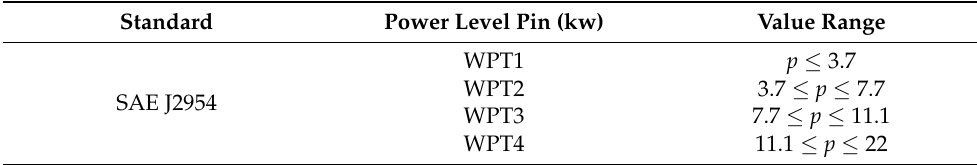
Table 1. Classification of WPT system for electric vehicles in SAE J2954.